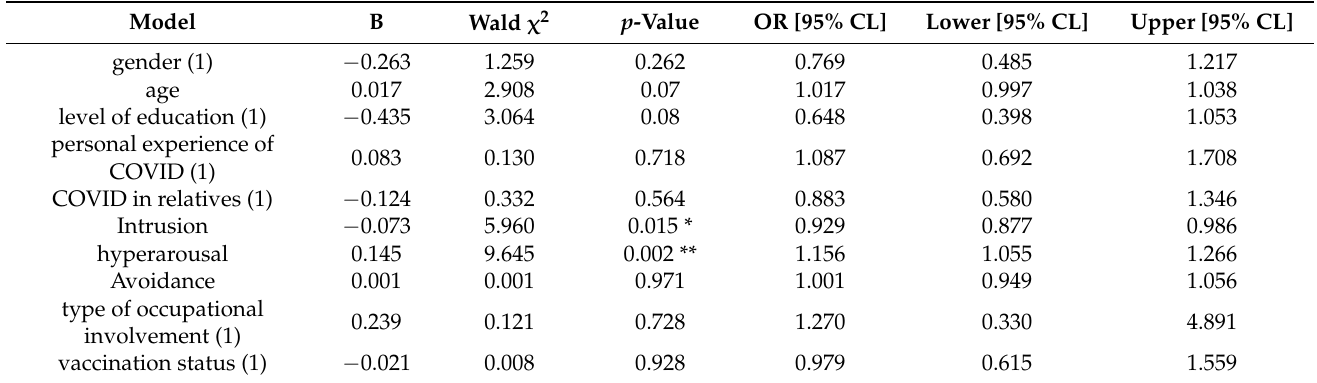
Table 6. Logistic regression analysis (enter method with likelihood ratio) associated with factors possibly related to sense of negative changes in life caused by the